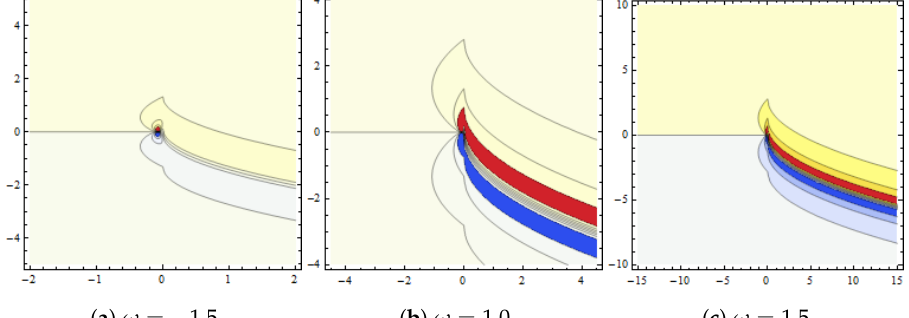
Figure 15. ( a – c ) show 2D plots.